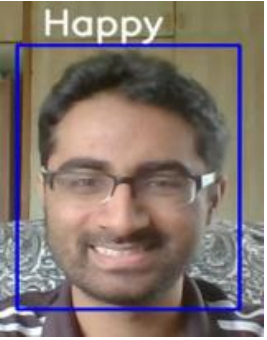
Figure 10. Seven kinds of facial expressions: ( a ) anger; ( b ) disgust; ( c ) fear; ( d ) happiness; ( e ) sadness;